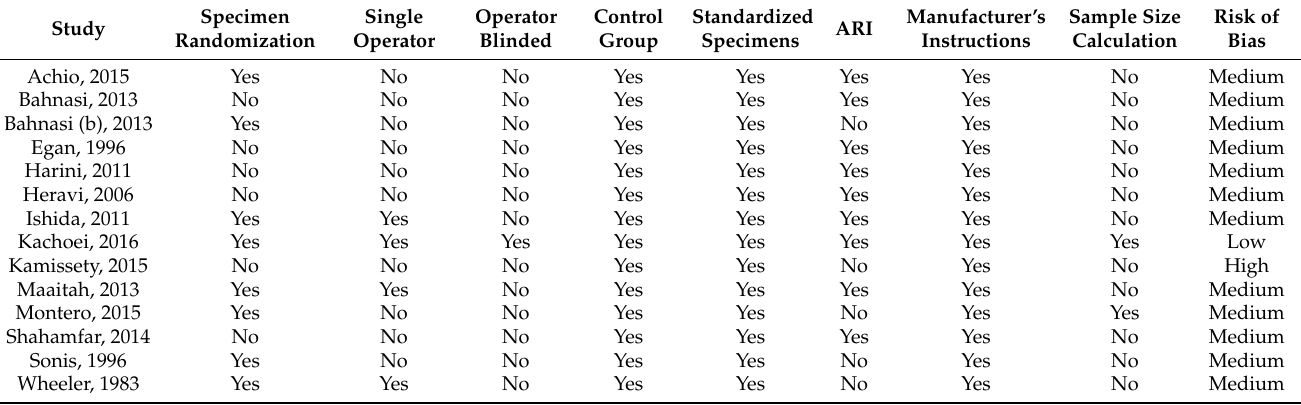
Table 3. Qualitative synthesis (risk of bias